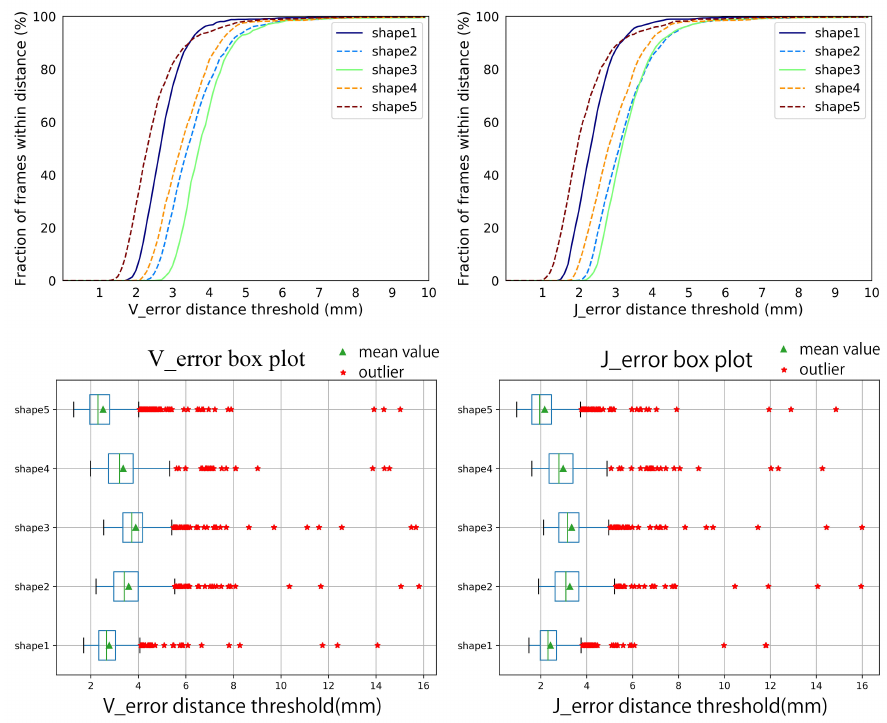
Figure 15. The V error and J error of our system on the five hand shapes and various hand poses in the synthetic